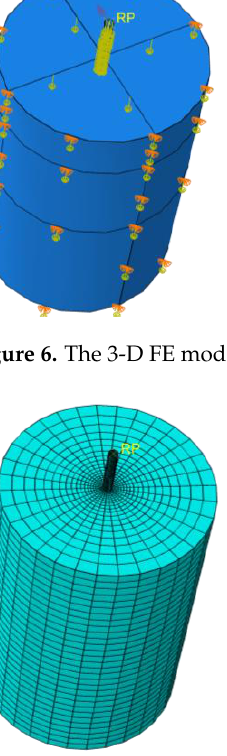
Figure 7. The 3-D FE model after completion of meshing.